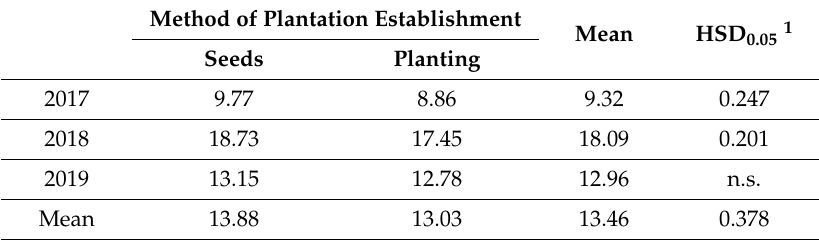
Table 10. DMY of Silphium (Mg · ha − 1 ) depending on methods of plantation establishment. Method of Plantation Establishment Mean HSD 0.05 1 Seeds